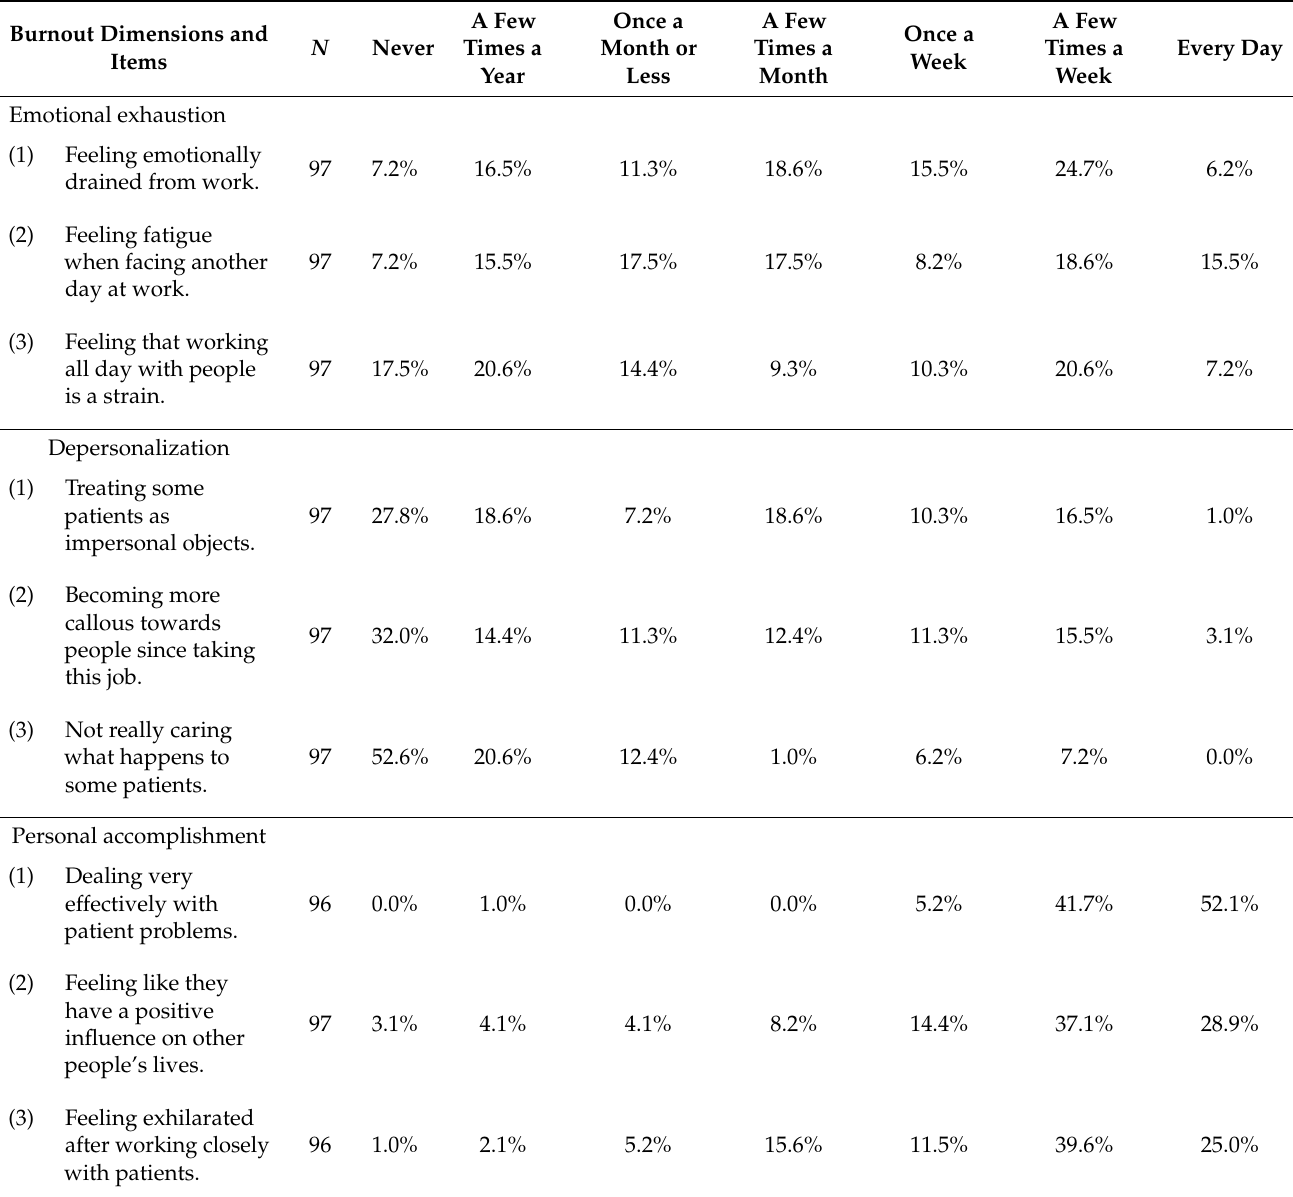
Table 2. Results of the abbreviated Maslach Burnout Inventory in the group of pediatric